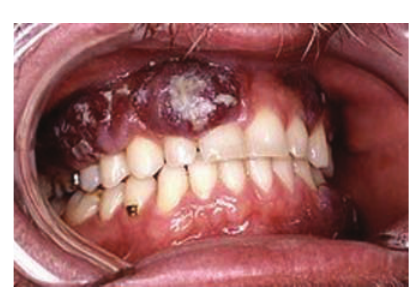
Figure 9. Kaposi’s sarcoma.